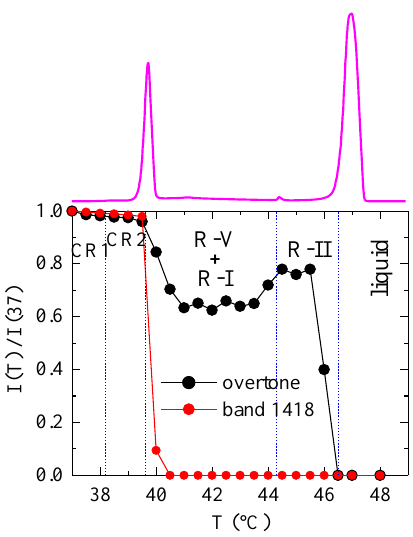
Figure 9. Variation in temperature of the ratio of intensity at temperature T to that at 37 °C for the first overtone and for the band at 1418 cm −1 . The corresponding DSC heating curve is also shown at the top.